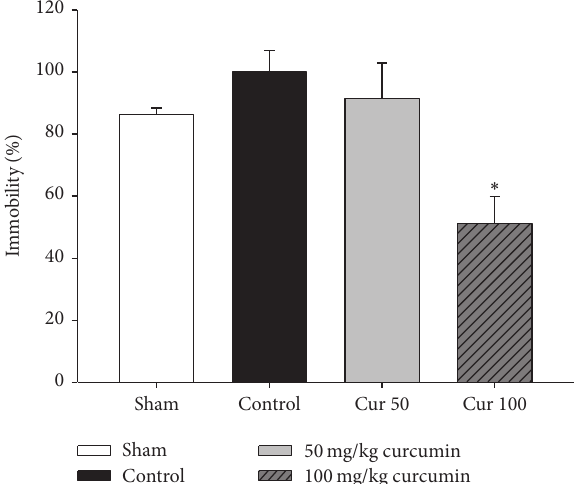
Figure 5: Effects of chronic stress and curcumin treatment on body weight in SD rats. Data represent mean ± SEM ( 𝑛 = 4 /group). ∗ 𝑝 < 0.05 by GLMM or Kruskal-Wallis test.